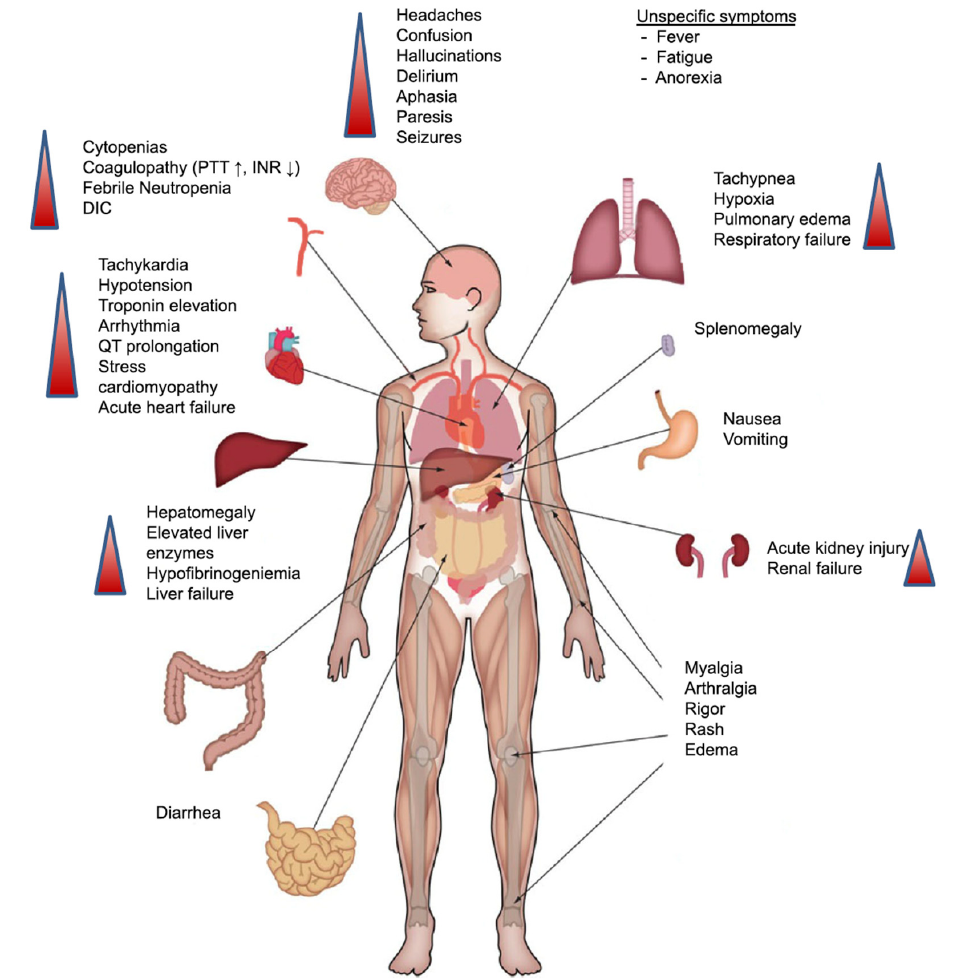
Figure 2. Clinical presentation of CRS. Symptoms can range from fever to the affection of multiple organs. Abbreviations: DIC: disseminated intravascular coagulation; INR: international normalised ratio; PTT: partial thromboplastin time. Reprinted from Alexander Shimabukuro-Vornhagen et al. J Immunother Cancer 2018;6:56 with permission from the Journal for ImmunoTherapy of Cancer [16].